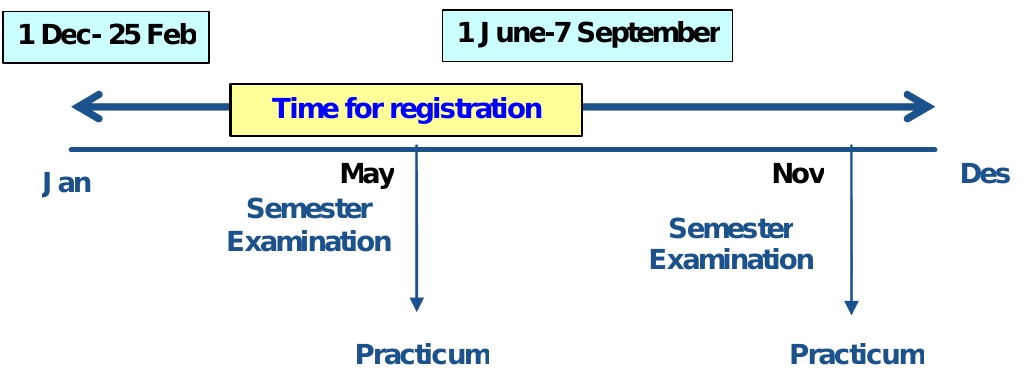
Figure 4. Practicum implementation